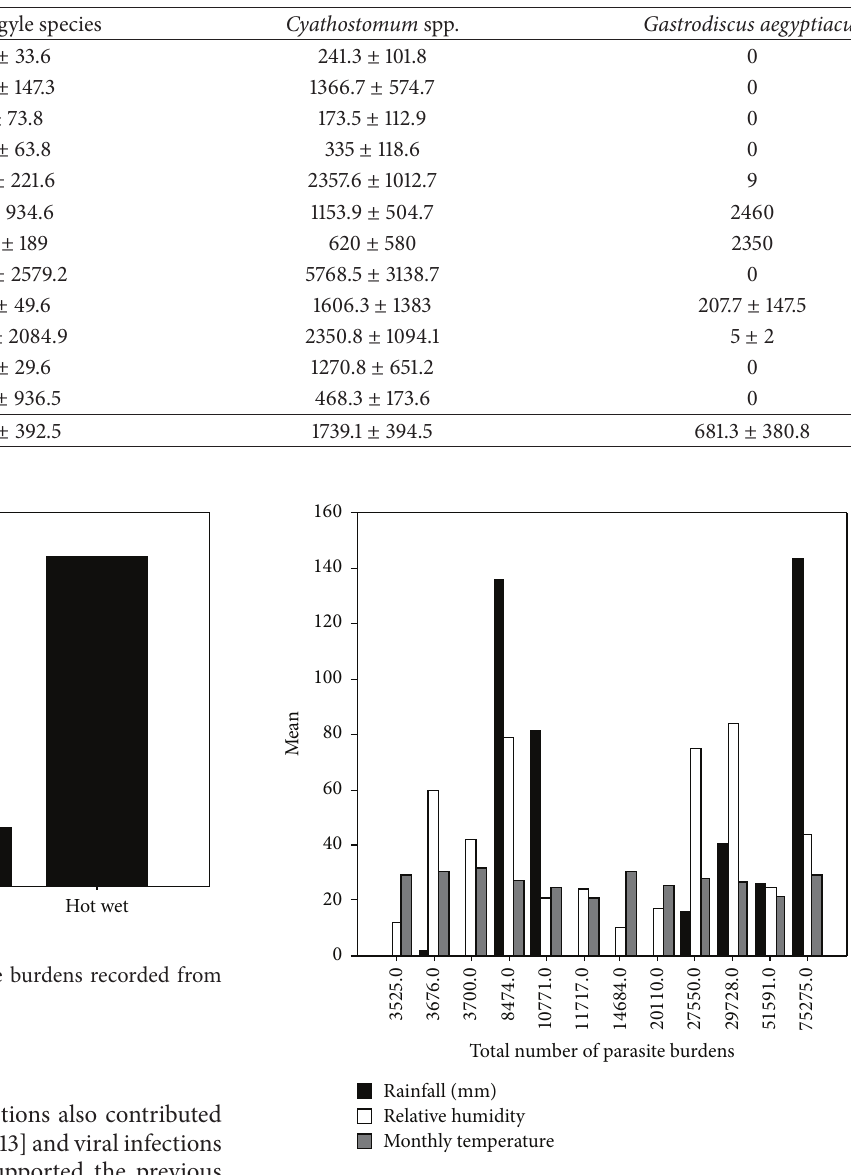
Figure 5: Effect of climatic factors on the internal parasitic burdens recovered from examined